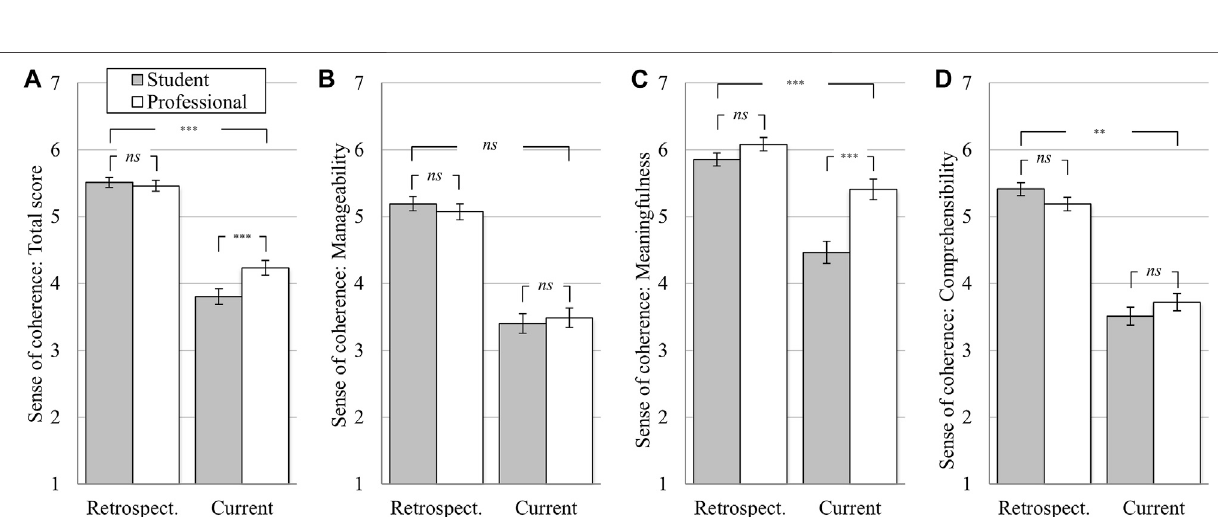
Frontiers in Sociology |